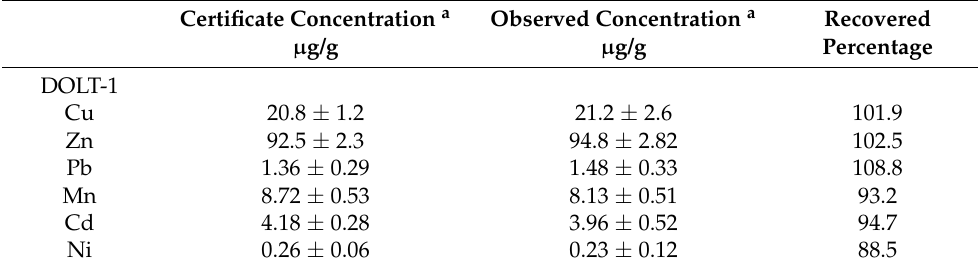
Table 1. Cd, Cu, Mn, Ni, Pb, Zn concentrations ug/g (dry weight) in the DOLT-1 certified fish reference material (liver) from the National Research Council Canada.